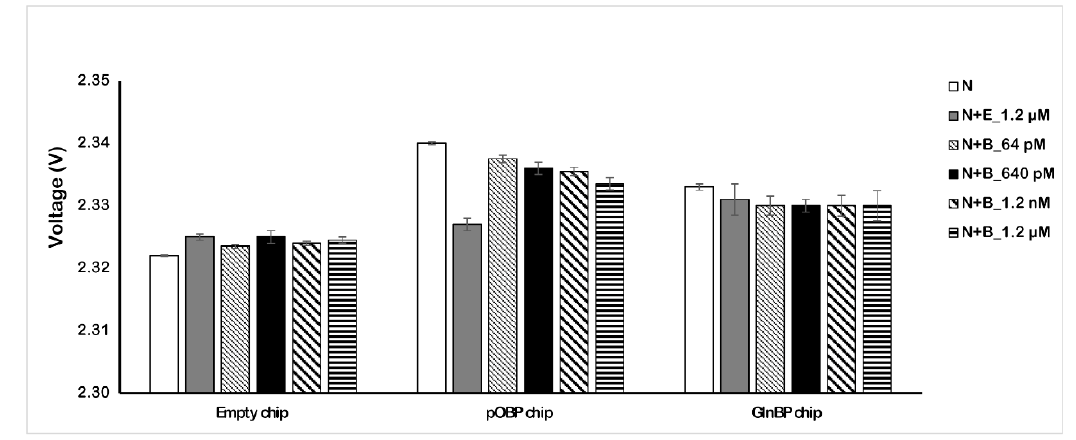
5 of 11 Figure 4. Gas test chamber. Schematic representation of the test chamber ( a ); real picture of the re- alized and used test chamber ( b ). Figure 5 shows the variation of the impedance signal in the absence and in the pres- ence of different benzene concentration values dissolved in the nitrogen flow. The ob- tained results show the different behavior of the signal as a consequence of the benzene presence in the gas. In particular, in these conditions, we registered a reduction (6 mV) in